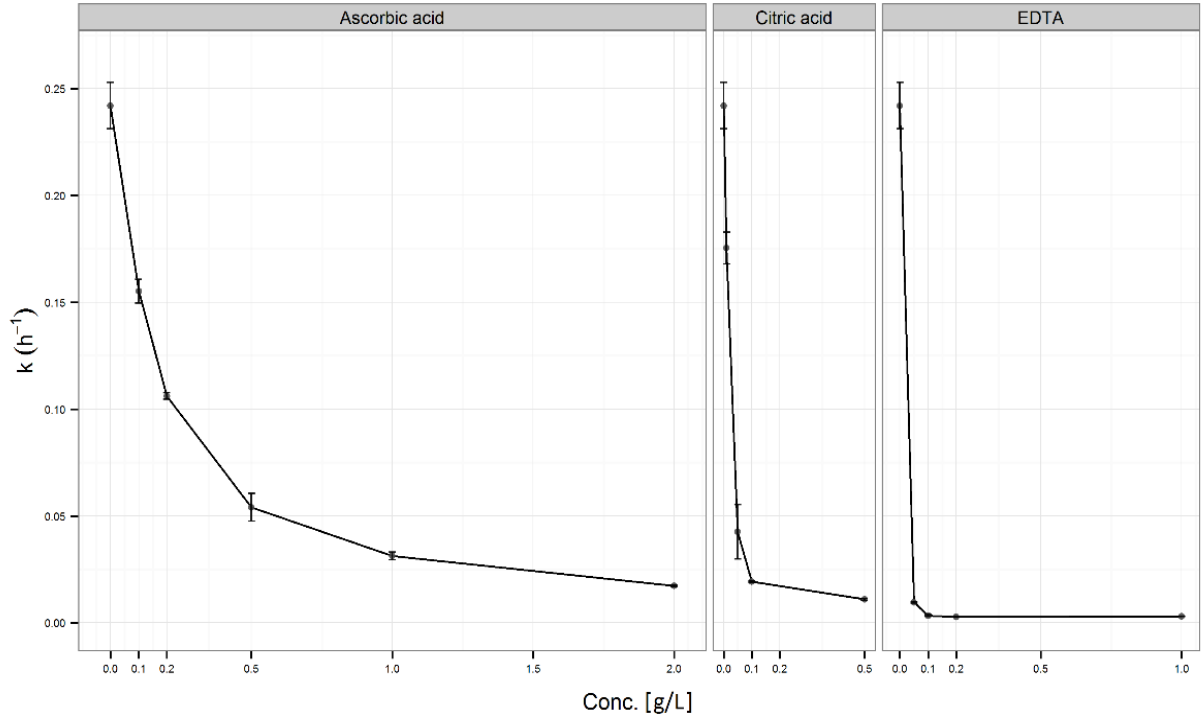
Figure 5. First-order rate constants for vitamin D3 degradation as a function of different concentrations of ascorbic, citric acid, or EDTA at 25 °C ( n = 3).